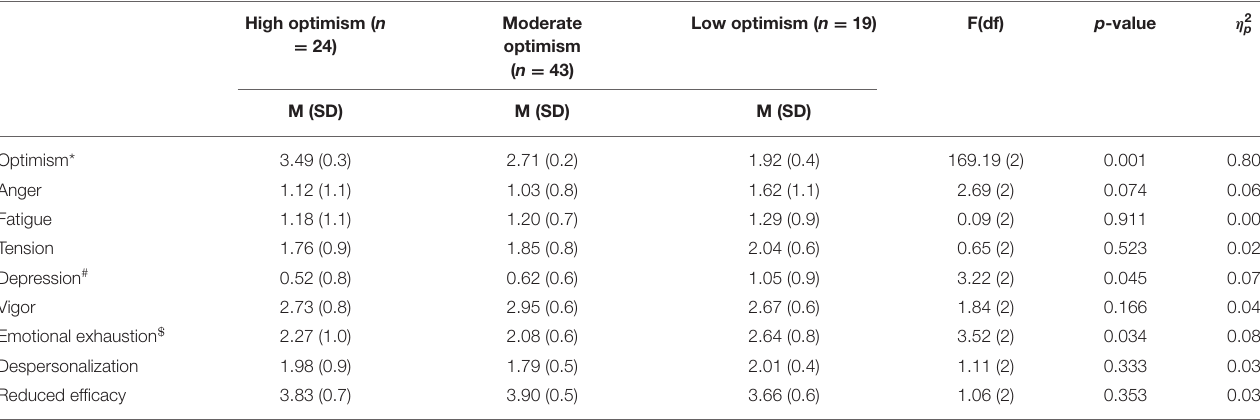
TABLE 3 | Average scores for each variable in the three clusters.